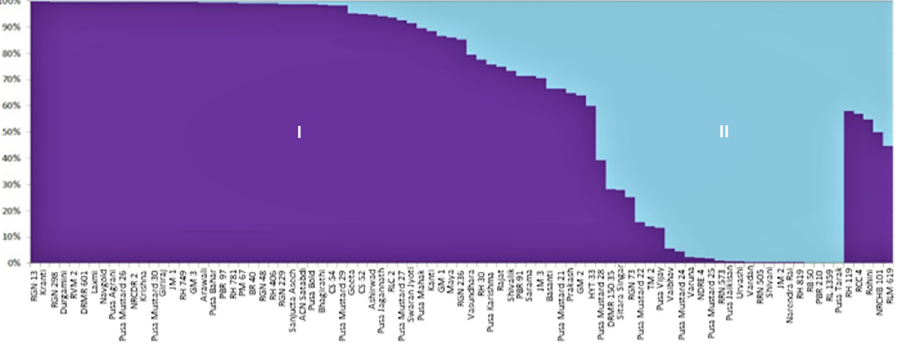
Fig 3. Population structure of 87 Indian mustard varieties on the basis of allelic data of 174 SSR